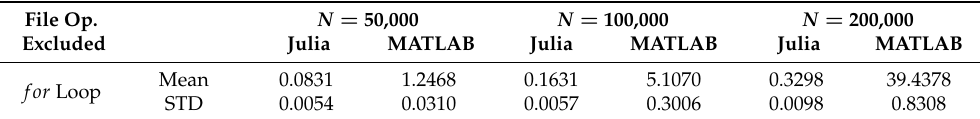
Table 5. Mean execution times and standard deviations of the compressible Blasius equations solver written in MATLAB and Julia. The mean execution times are given in second. Ten data points are used in the calculation of the mean and the standard